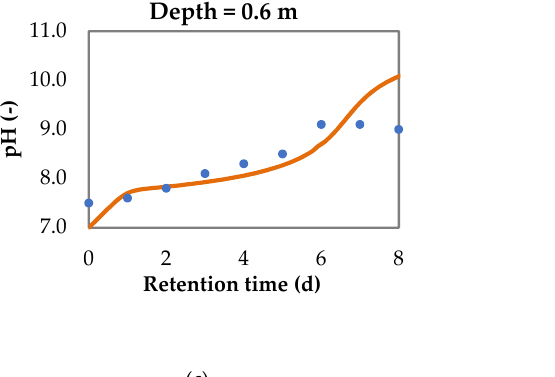
Figure 4. ( a ) Experimental data and simulated curve for pH as function of time for SBPP with a depth of 0.2 m; ( b ): Exper- imental data and simulated curve for pH as function of time for SBPP with a depth of 0.4 m, ( c ): Experimental data and simulated curve for pH as function of time for SBPP with a depth of 0.6 m, ( d ): Experimental data and simulated curve for pH as function of time for SBPP with a depth of 1.0 m.